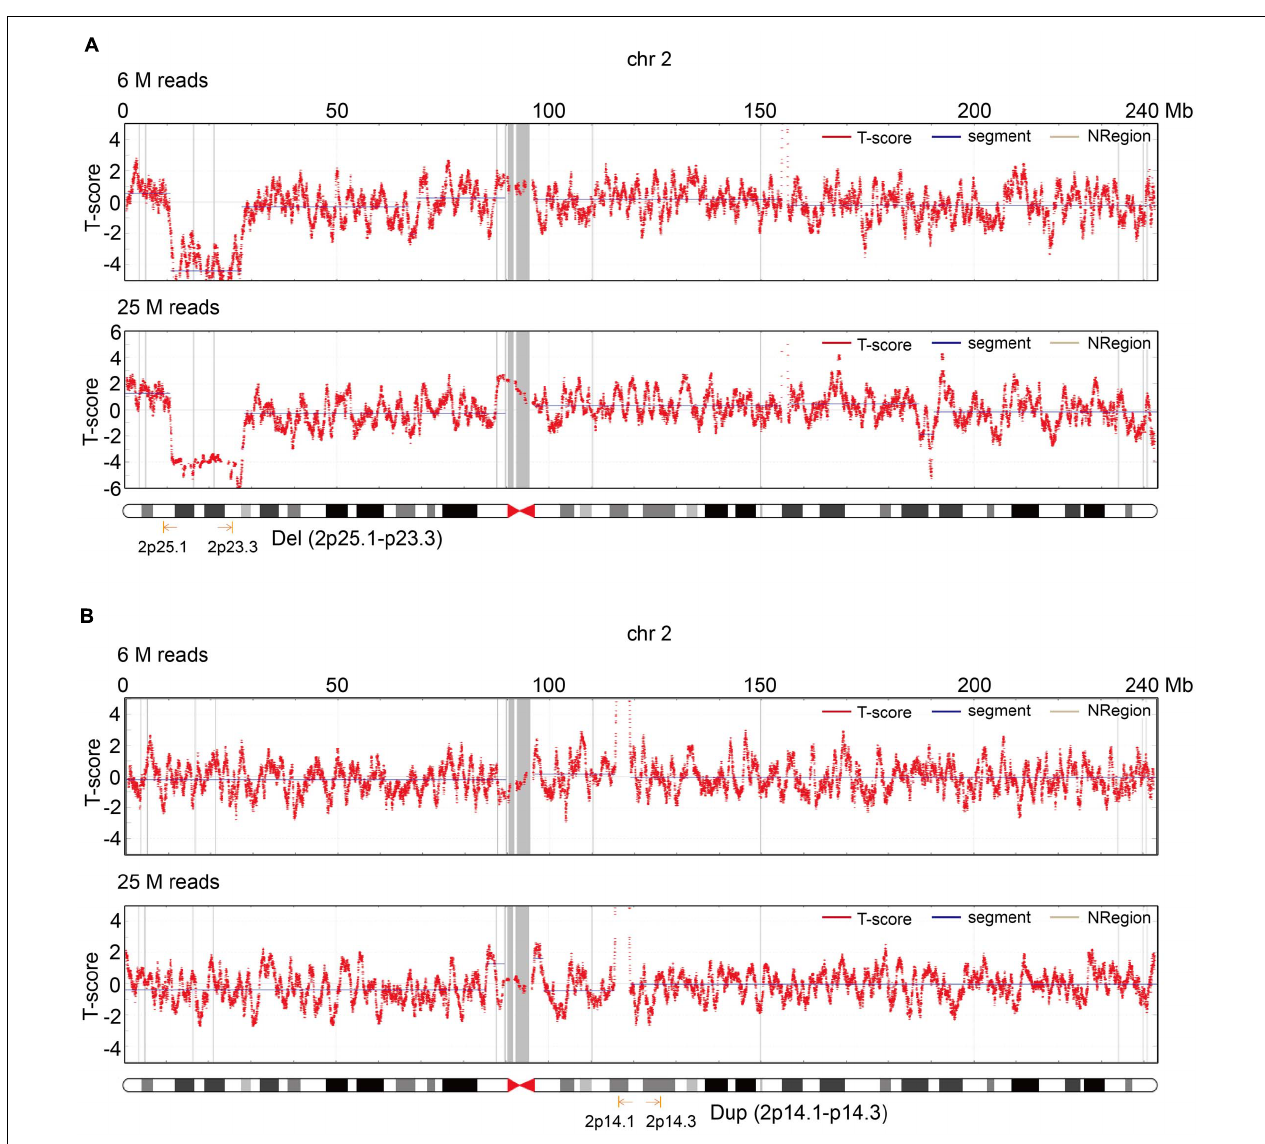
FIGURE 5 | Two cases that illustrate the role of read depth for fetal CNV detection. (A) T -score of chr2 in the read depth of 6 and 25 M in the first case. (B) T -score of chr2 in the read depth of 6 and 25 M in the second